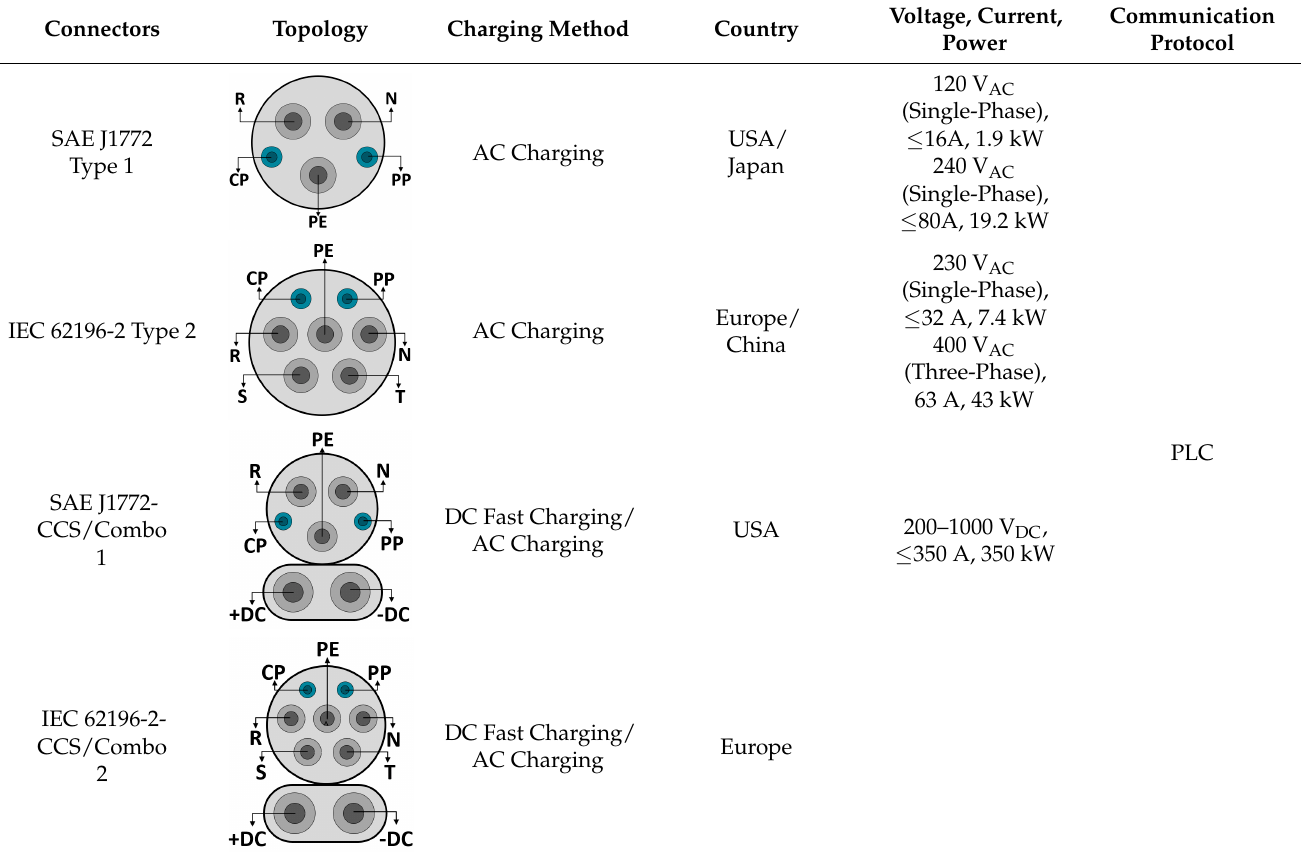
Table 2. Standards of charging connectors [4,25,30].